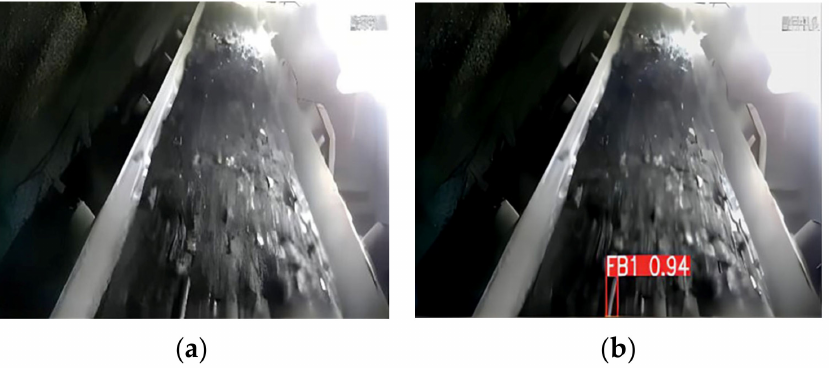
Figure 11. Comparison of recognition results of YOLOv5 before and after improvement. ( a ) Recognition results of the original YOLOv5 algorithm ( b ) Recognition results of the improved YOLOv5